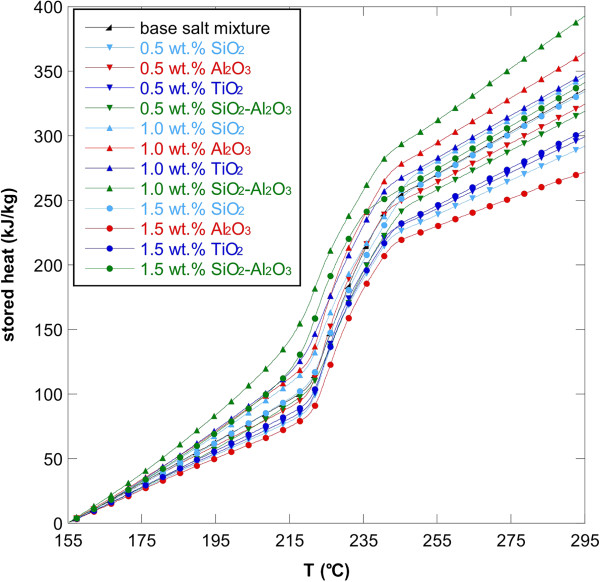
Stored heat versus temperature for NaNO3-KNO3 binary salt mixture and nanofluids. Obtained with base salt and 0.5, 1.0, and 1.5 wt.% of oxide nanoparticles.